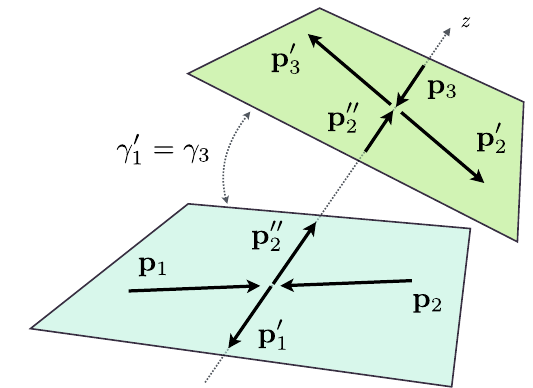
Fig. 20 Relation between the initial and final IRF planes for the OPE amplitude